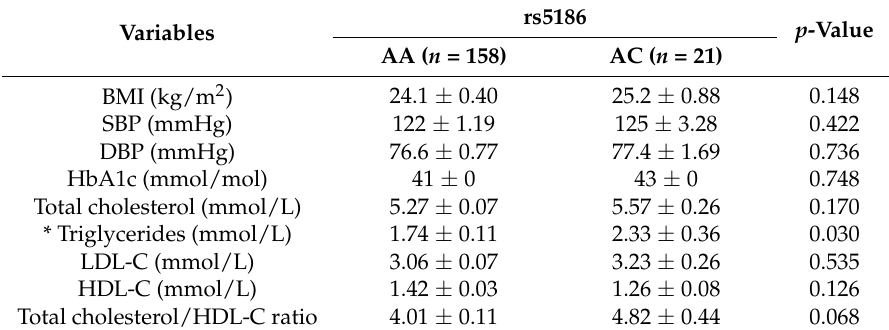
Table 3. Values of CVD metabolic risk factors according to the genotype of the AGTR1 gene rs5186 SNP for Chinese subjects ( n =